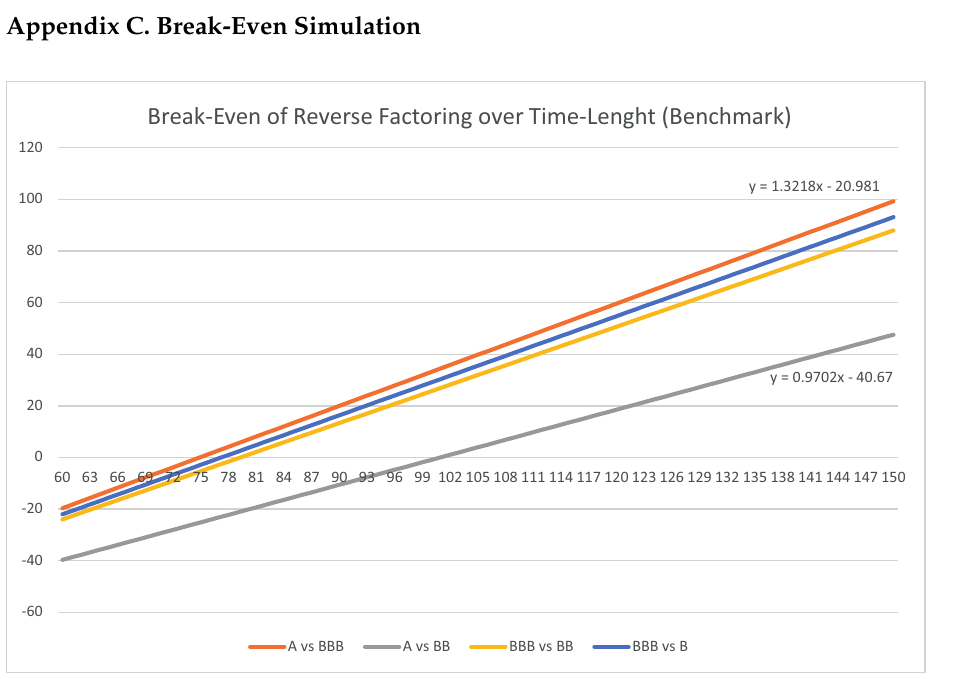
Figure A1. Break-even points. Source: Authors’